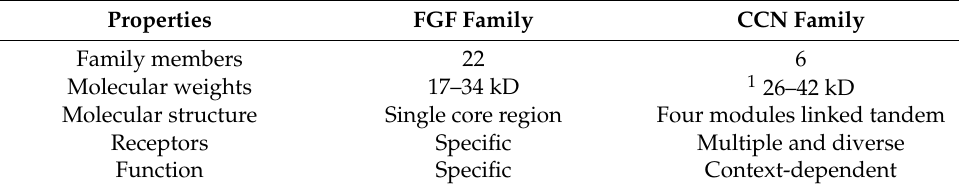
Table 1. Distinct properties of mammalian CCN and FGF family